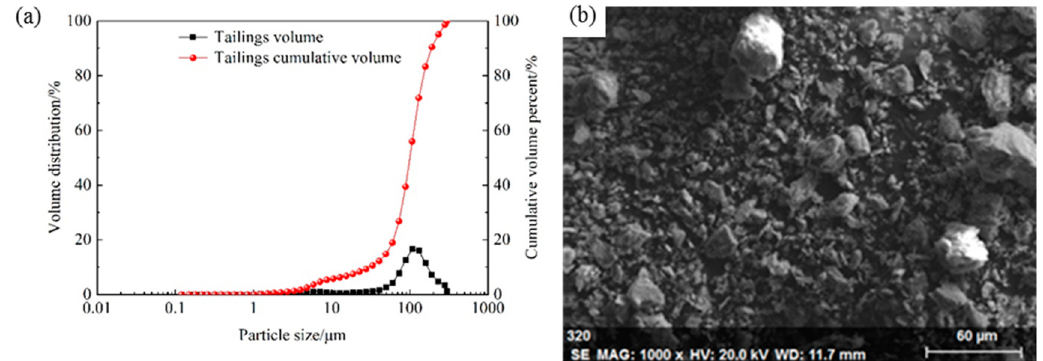
Figure 3. ( a ) Particle size distribution and ( b ) microstructure of the tailings.